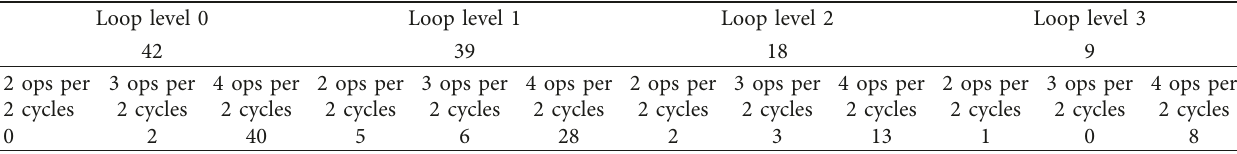
Table 7: Distribution of Speex move-move instructions based on loop level and number of operations per 2 clock